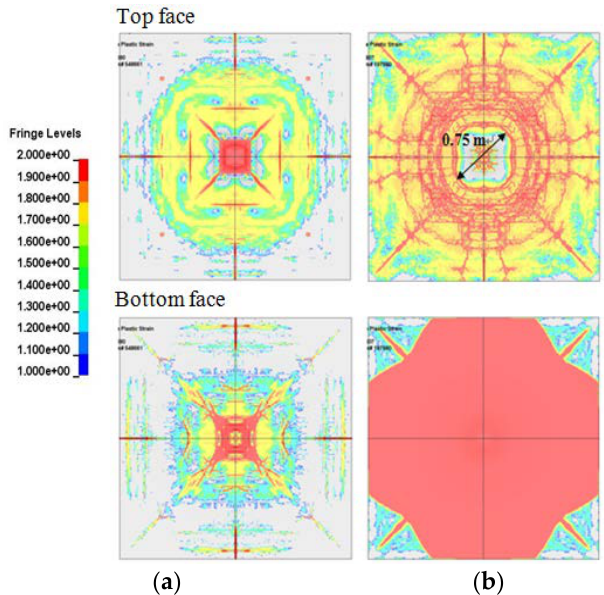
Figure 12. Damage contour for the AC and HSC layer in the multi-layers pavement: ( a ) damage contour of the AC layer in the numerical simulation; ( b ) damage contour of the HSC layer in the numerical simulation. Table 7. Vertical acceleration of the multi-layer pavement slab.